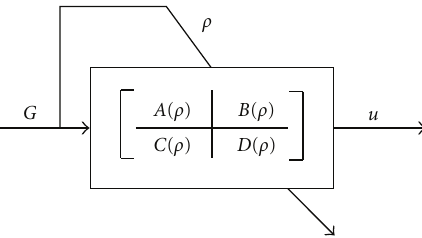
Figure 1: LPV controller implementation, where G is the plasma- glucose concentration above the basal value G b , input u is the insulin infusion rate and ρ is the time-varying measurable parameter, in this case ρ = G